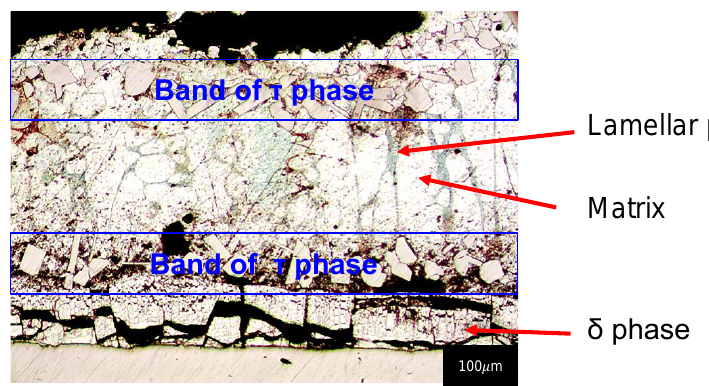
Figure 10. Coating microstructure from Zn-Ti 0.5% bath.